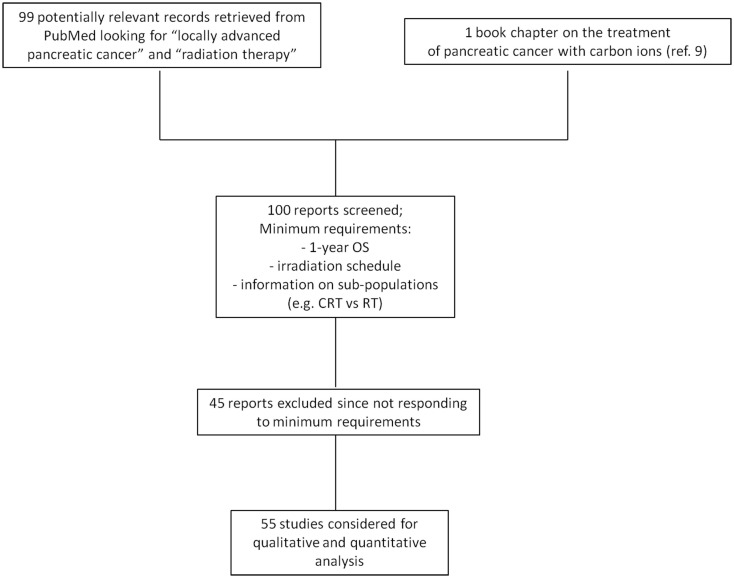
Diagram summarizing the selection criteria of the studies included in the analysis.